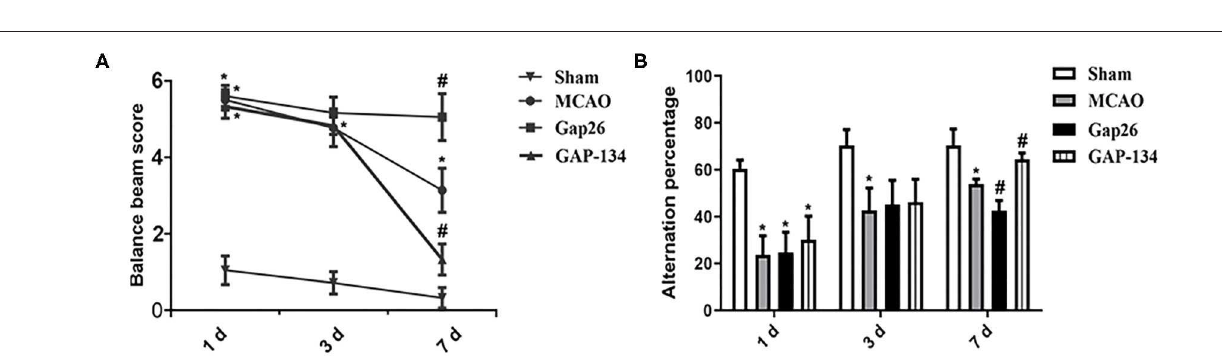
FIGURE 2 | Effects of Gap26 and GAP-134 on balance beam walking test and Y-maze test at 1, 3, and 7 d after MCAO. Data were presented as mean ± SEM, n = 6. (A) Compared with MCAO, Gap26 significantly increased the balance beam score while GAP-134 decreased it at 7 d. (B) Compared with MCAO, Gap26 downregulated the alternation percentage; however, GAP-134 upregulated it at 7 d (* P < 0.05 vs. sham, # P < 0.05 vs.